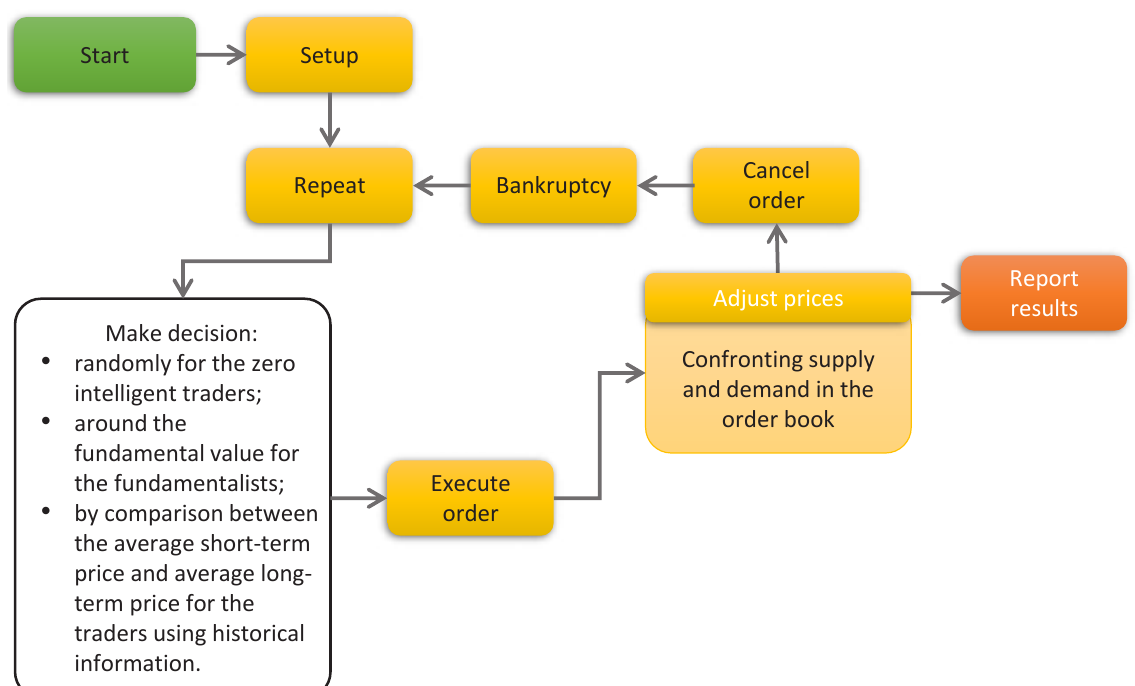
Figure 2. Flow chart of the algorithm implemented for the developed